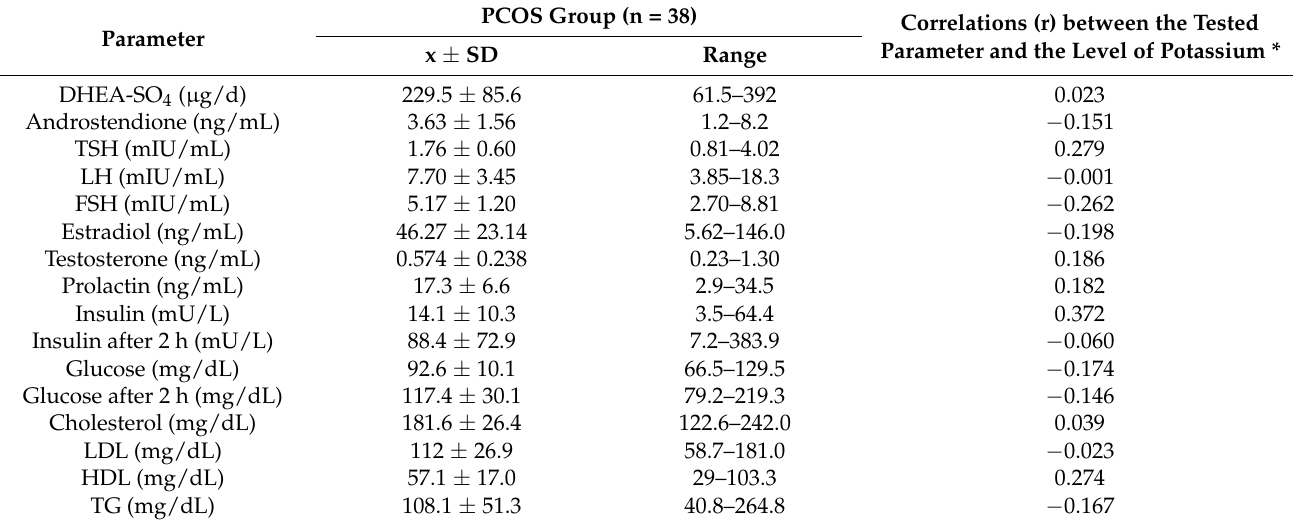
Table 4. Correlations of the anthropometric and biochemical parameters of PCOS patients in relation to the potassium levels in their red blood